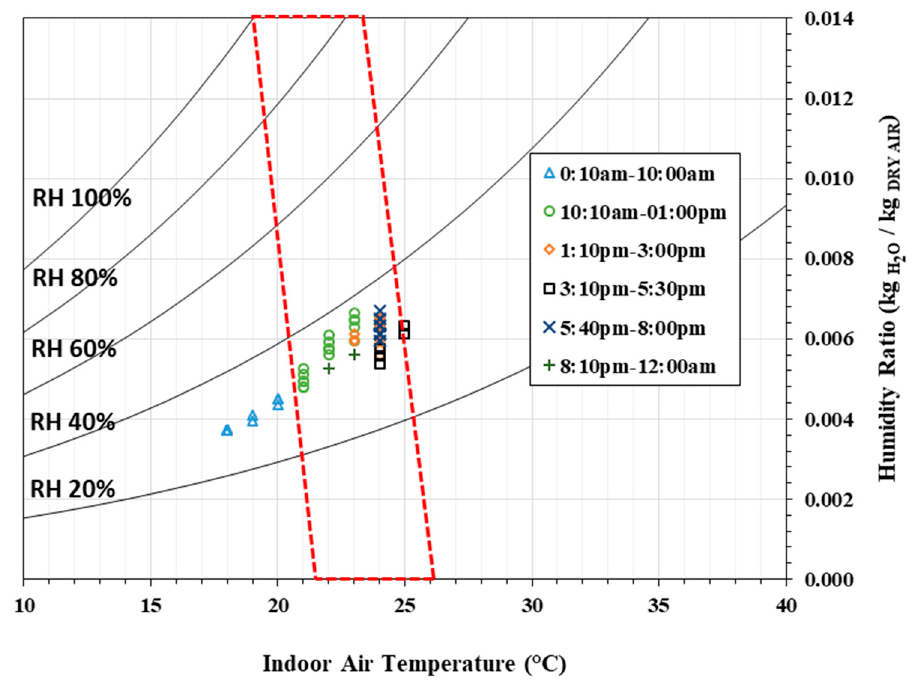
Figure 9. Psychrometric chart and time analysis on the day when the ERV system was off (24 February 2020).